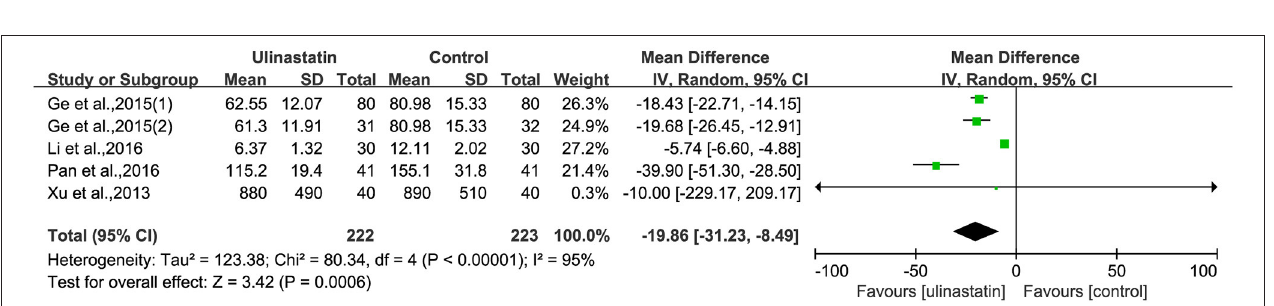
FIGURE 6 | Forest plot: Comparing plasma tumor necrosis factor (TNF)- α of patients receiving ulinastatin vs. control.